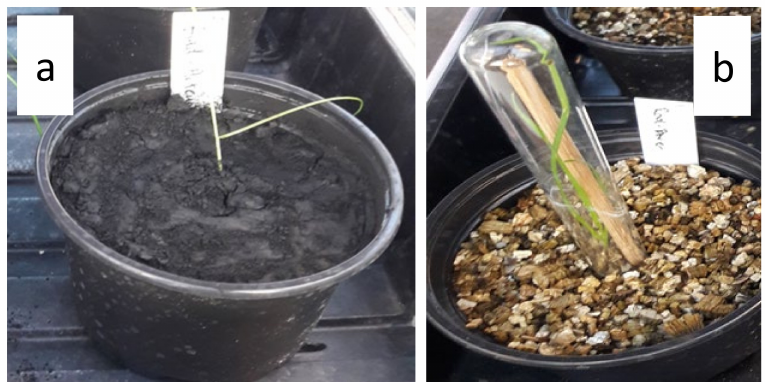
Figure 1. General overview of the experimental unity and the preparation for herbicide application. ( a ) A pot (Ø = 10 cm) with vermiculate and an emerging L. multiflorum plant after charcoal had